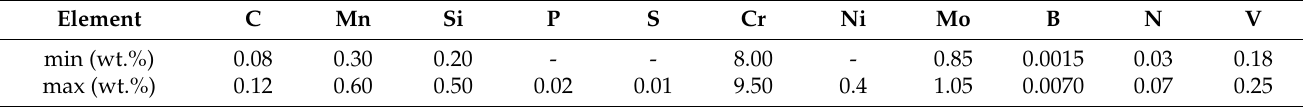
Table 1. Chemical composition of P91 steel.